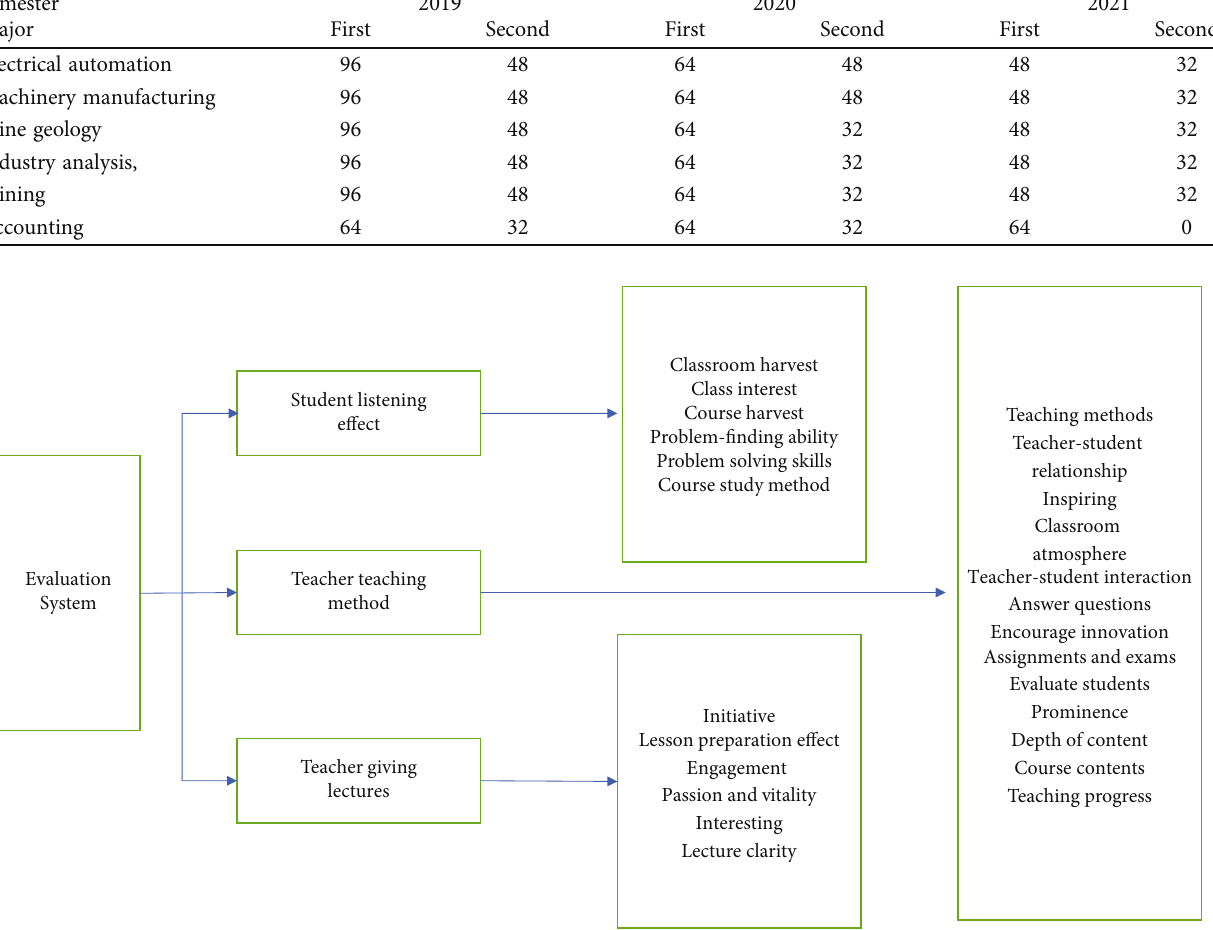
Figure 3: Evaluation index Table 7: Teaching evaluation grade standard.